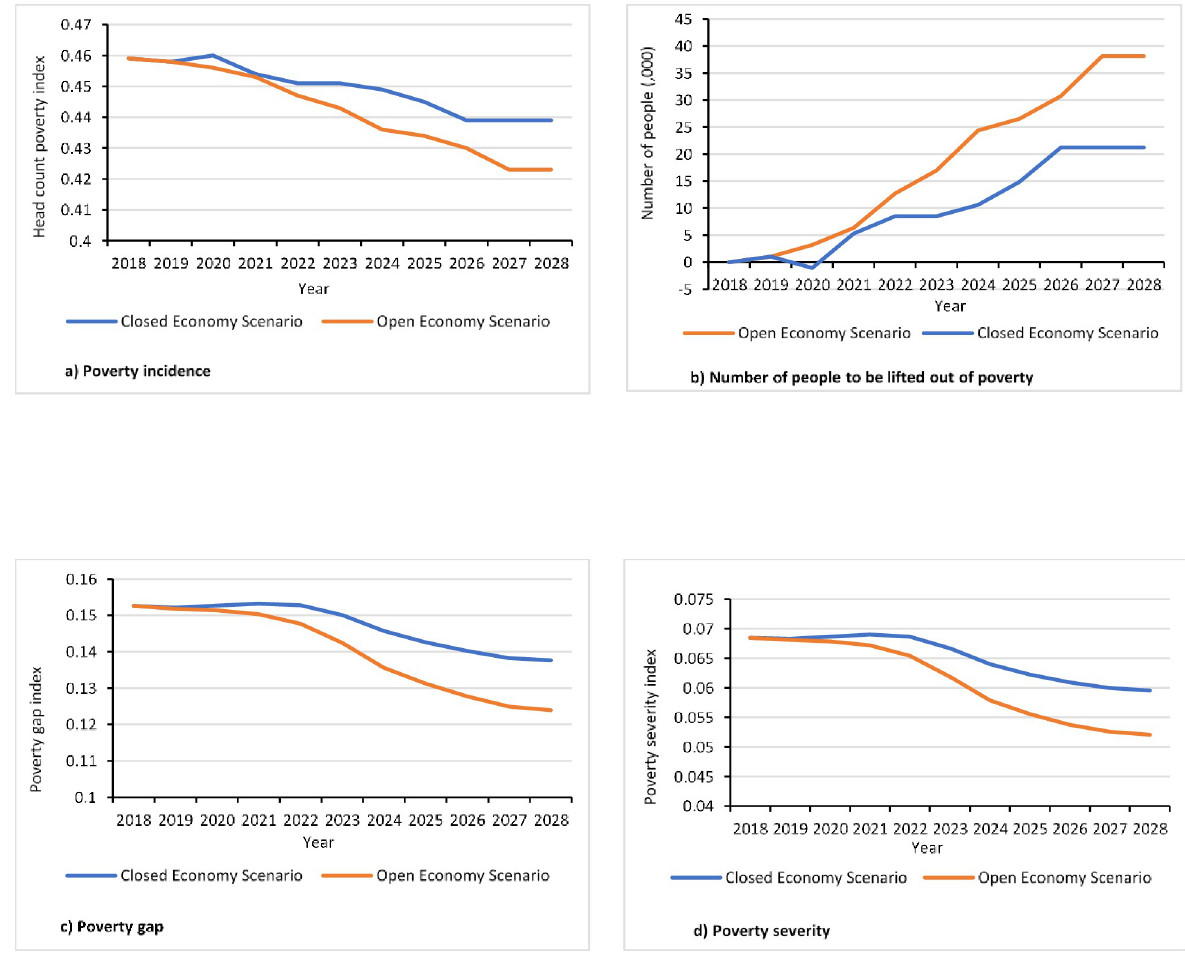
Fig 7. Impact of adoption of the new groundnut plant spacing on